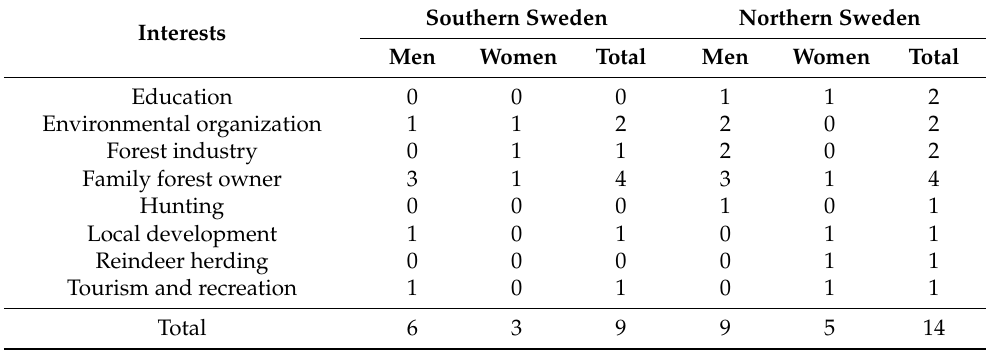
Table 1. The stakeholders participating in workshop